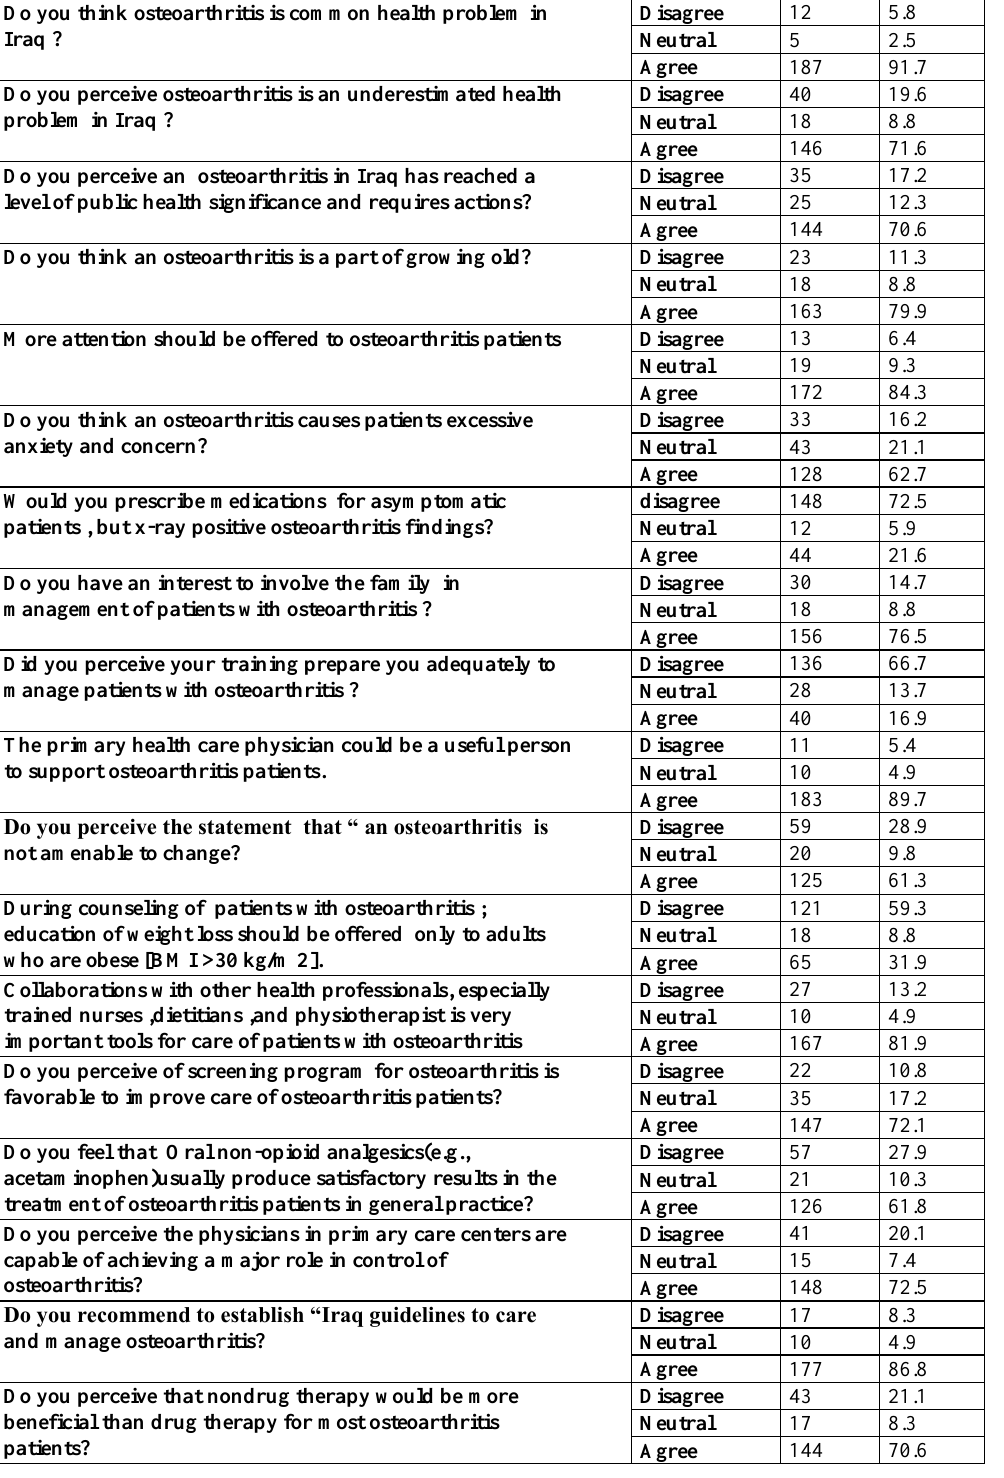
Table.5. Primary care physicians’ attitudes toward